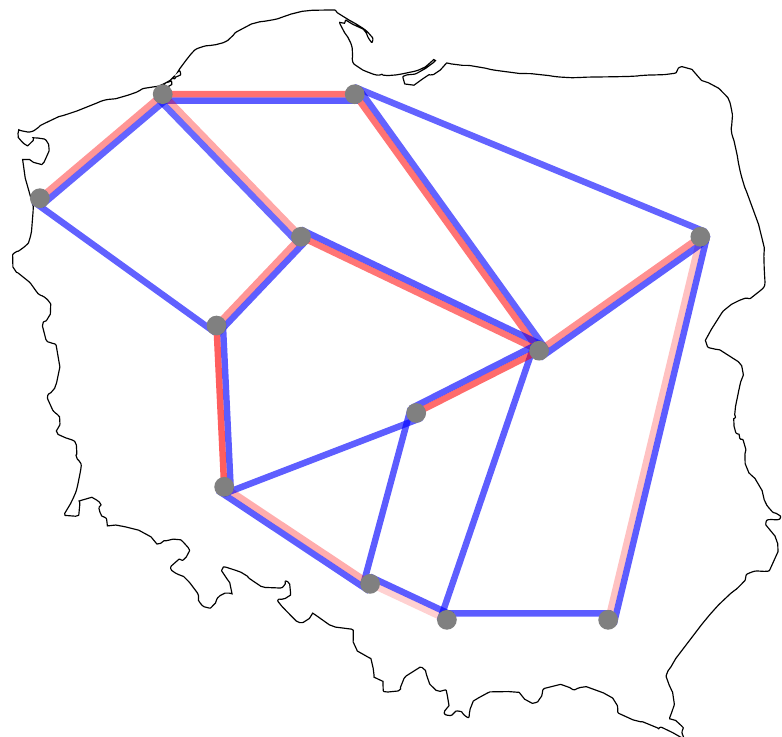
Figure 13. Wavelength assignment for band C and L (with max demand) for Polish